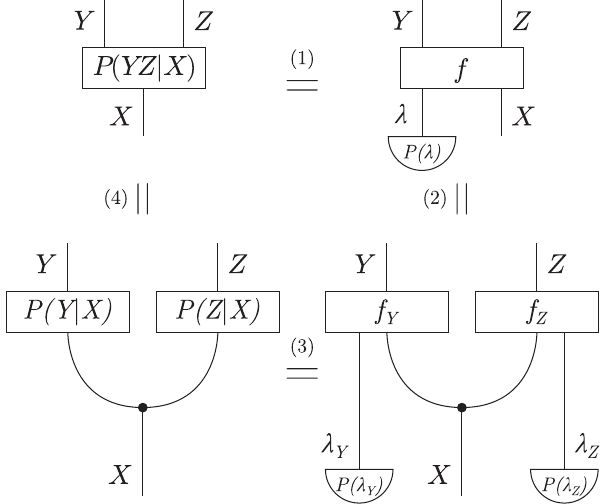
FIG. 5. Diagrammatic representation of Theorem 1 and of alternative expressions for conditional independence of outputs given input (the classical analogue of Theorem 3).